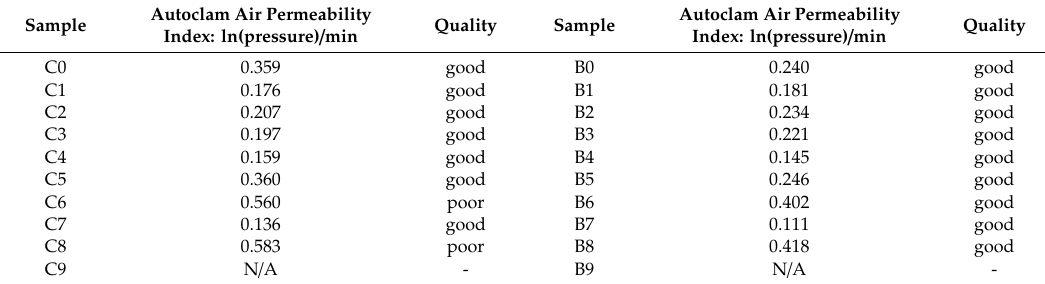
Figure 16. Behaviour of samples during permeability test (W/B = 0.30) for: ( a ) sample C0, ( b ) sample C1, ( c ) sample C6, and ( d ) sample C8. Table 4. Protective quality of the air permeability of